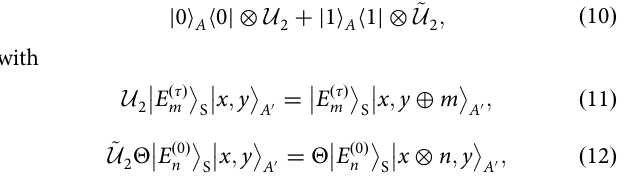
Fig. 2 in the case of two measurements outcomes for E ð 0 Þ